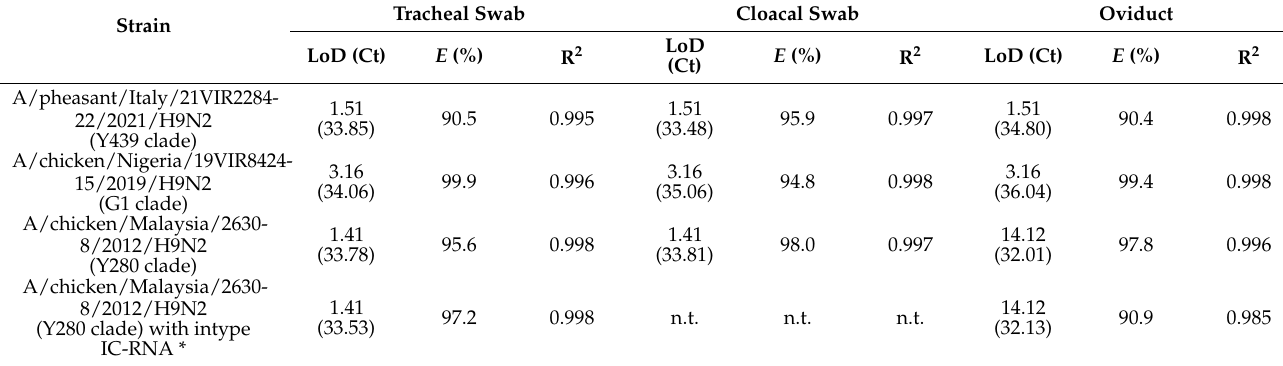
Table 3. Analytical sensitivity in tracheal swabs, cloacal swabs and oviduct homogenate for H9 Y439, G1 and Y280 clades. The LoD is expressed as EID 50 /100 µ L and mean Ct values. For each dilution series, the amplification efficiency E (%) and the coefficient of correlation R 2 are reported. n.t.: not